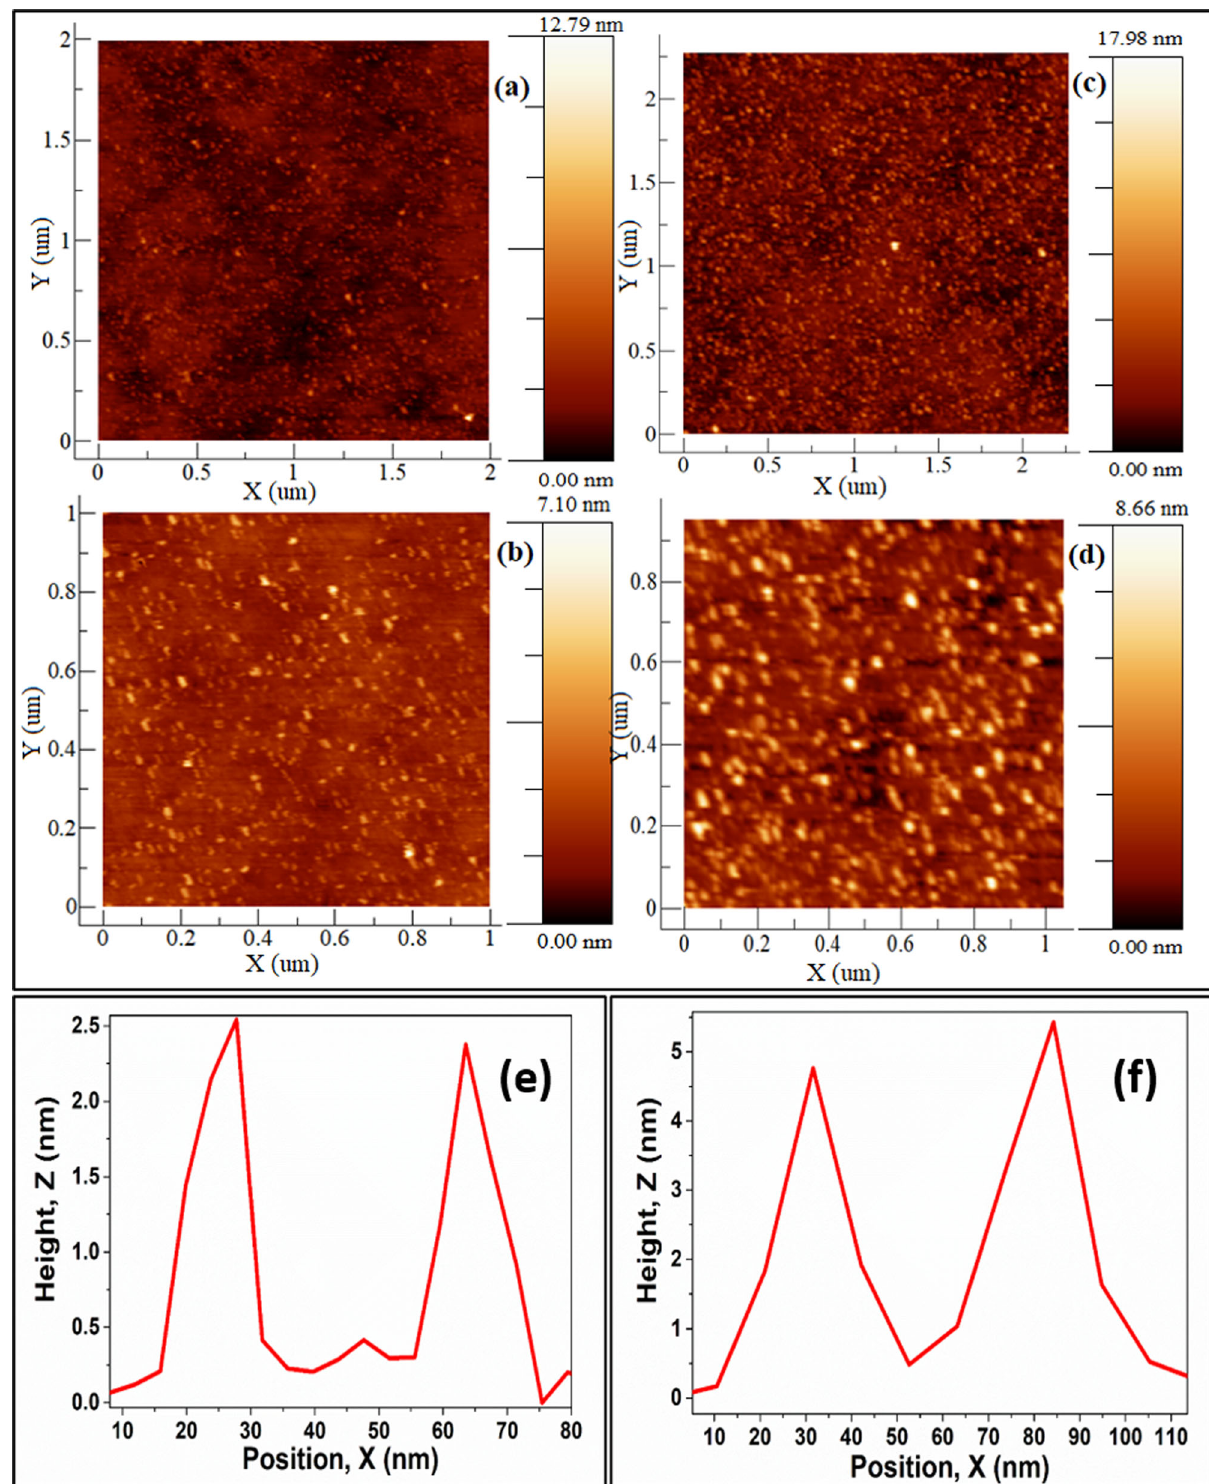
Fig. 2 AFM analysis determining the structural roughness. Tapping mode two-dimensional AFM images of a , b P4T, c , d P4T-D, the apparent height and diameter of isolated nanoparticles of e P4T and f